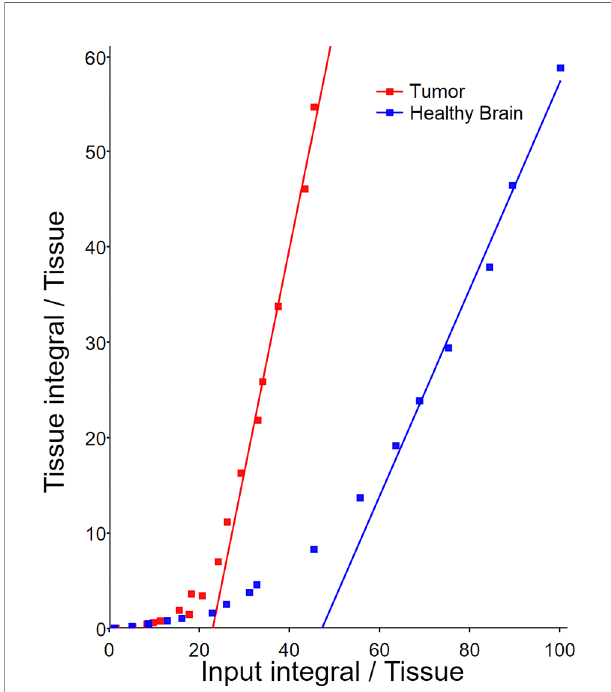
FIGURE 7 | Sample Logan plot of dynamic [ 18 F]FGln PET image tissue uptake with population-based metabolite-corrected bioavailable (free parent) plasma fraction of arterial blood as the